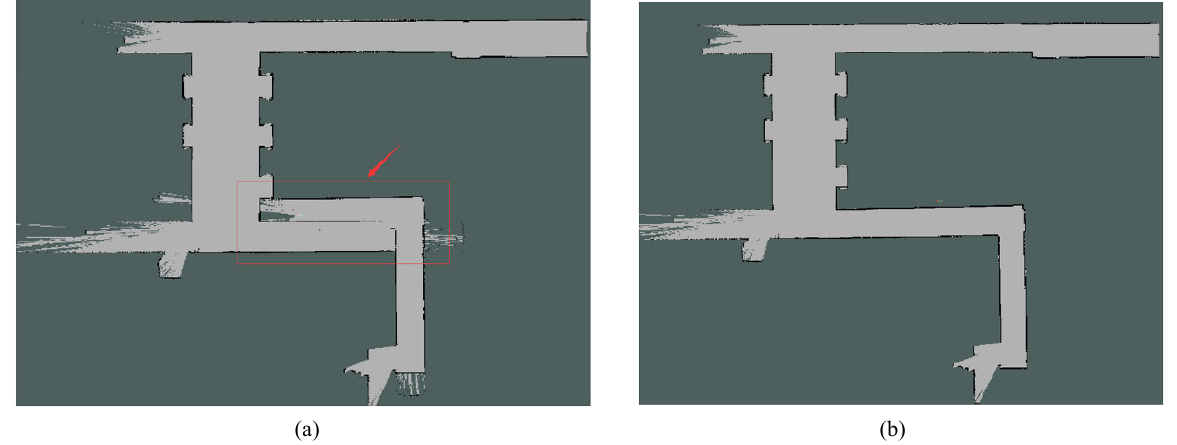
Fig. 14 Map of degraded map: (a) map built by cartographer and (b) map built by the proposed method.